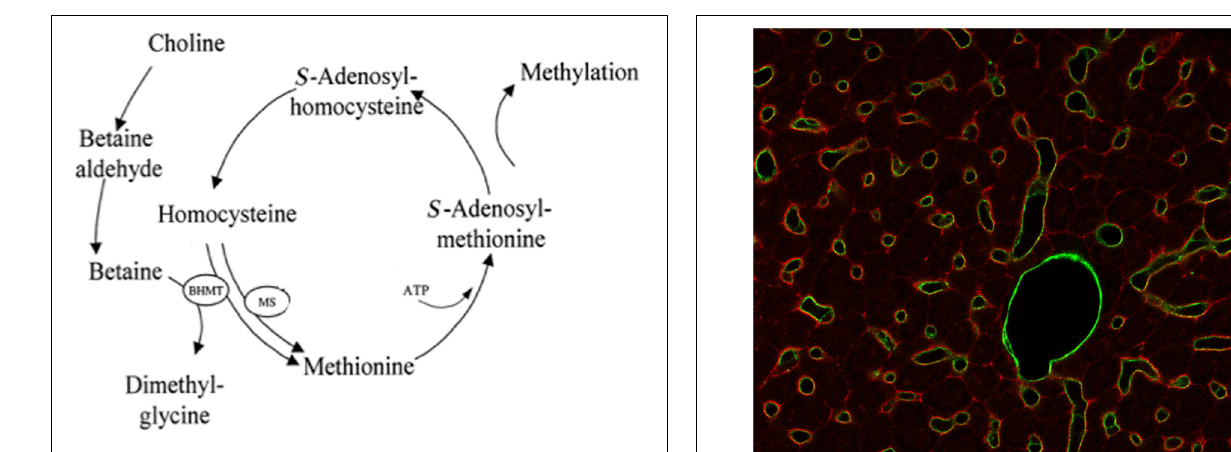
FIGURE 4 | Role of betaine in the methionine cycle in liver. Betaine provides an alternative pathway for methylation of homocysteine. BHMT,